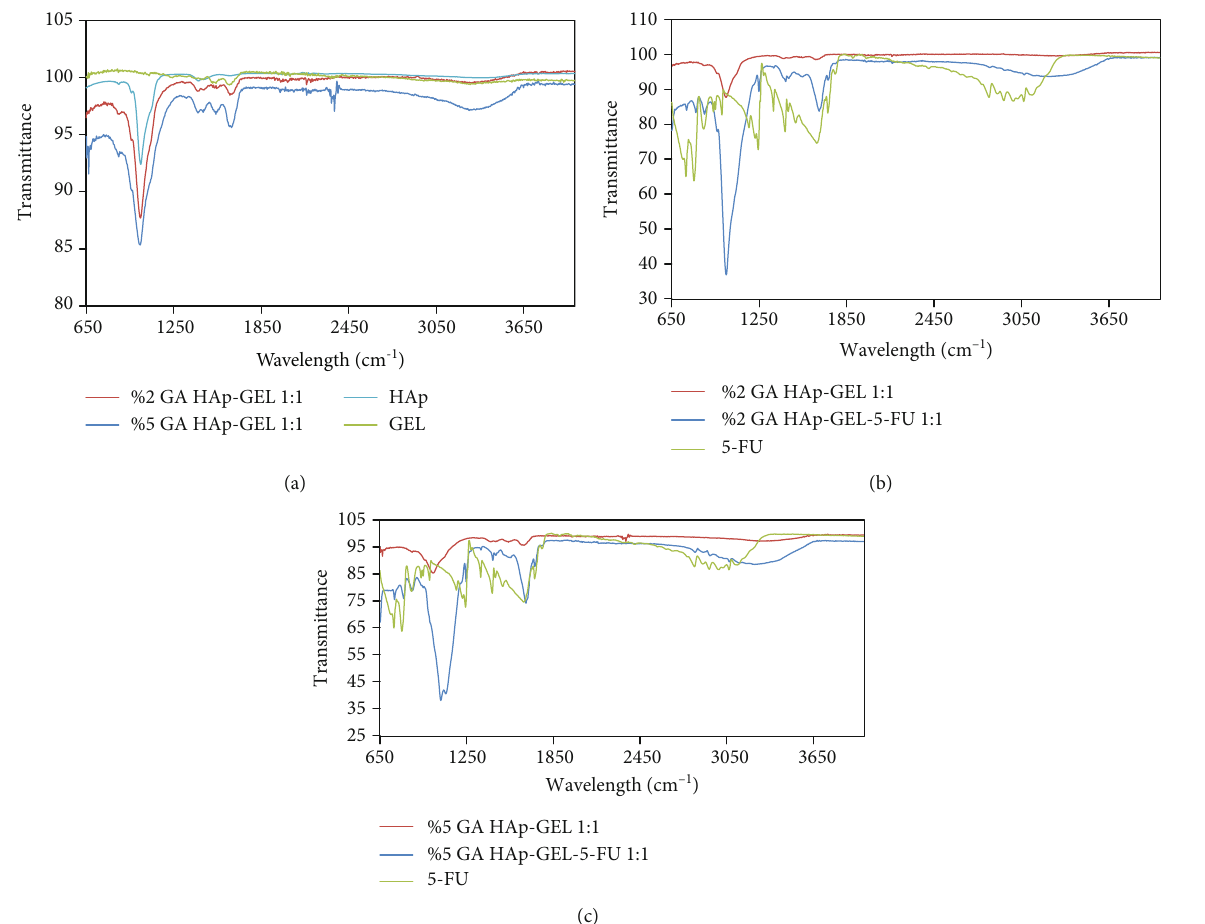
Figure 4: FTIR patterns of (a) the HAp-GEL composites cross-linked with di ff erent amounts of GA, pure HAp, and pure GEL; (b) the drug-loaded and unloaded 2% GA HAp-GEL composites, pure 5-FU; and (c) the drug-loaded and unloaded 5% GA HAp-GEL composites, pure